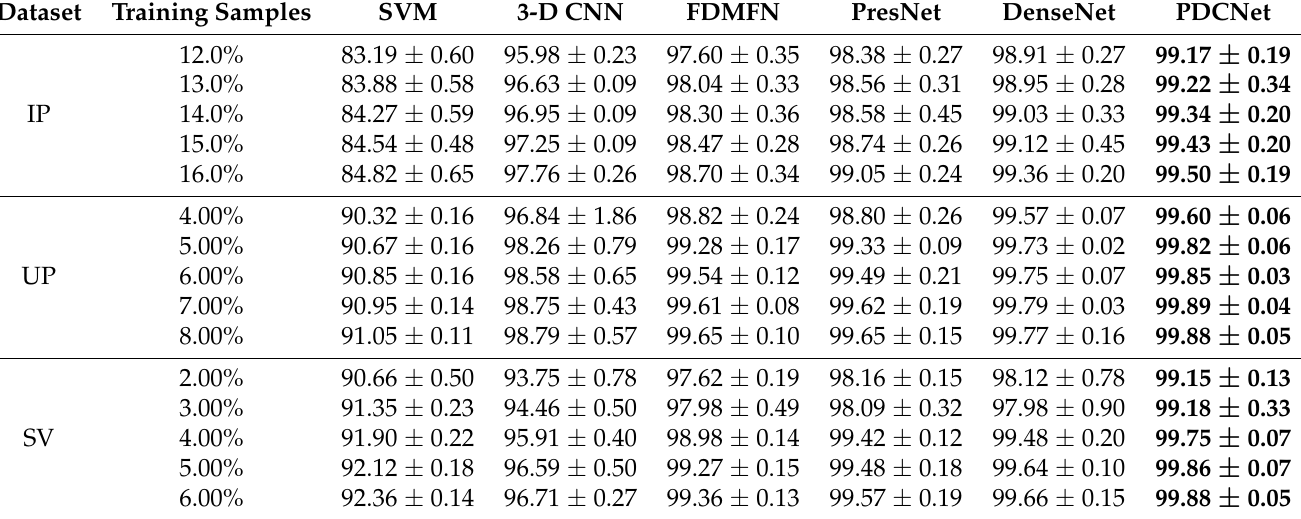
Table 12. OA(%) of different methods with different proportions of training samples. The best results are highlighted in bold font.